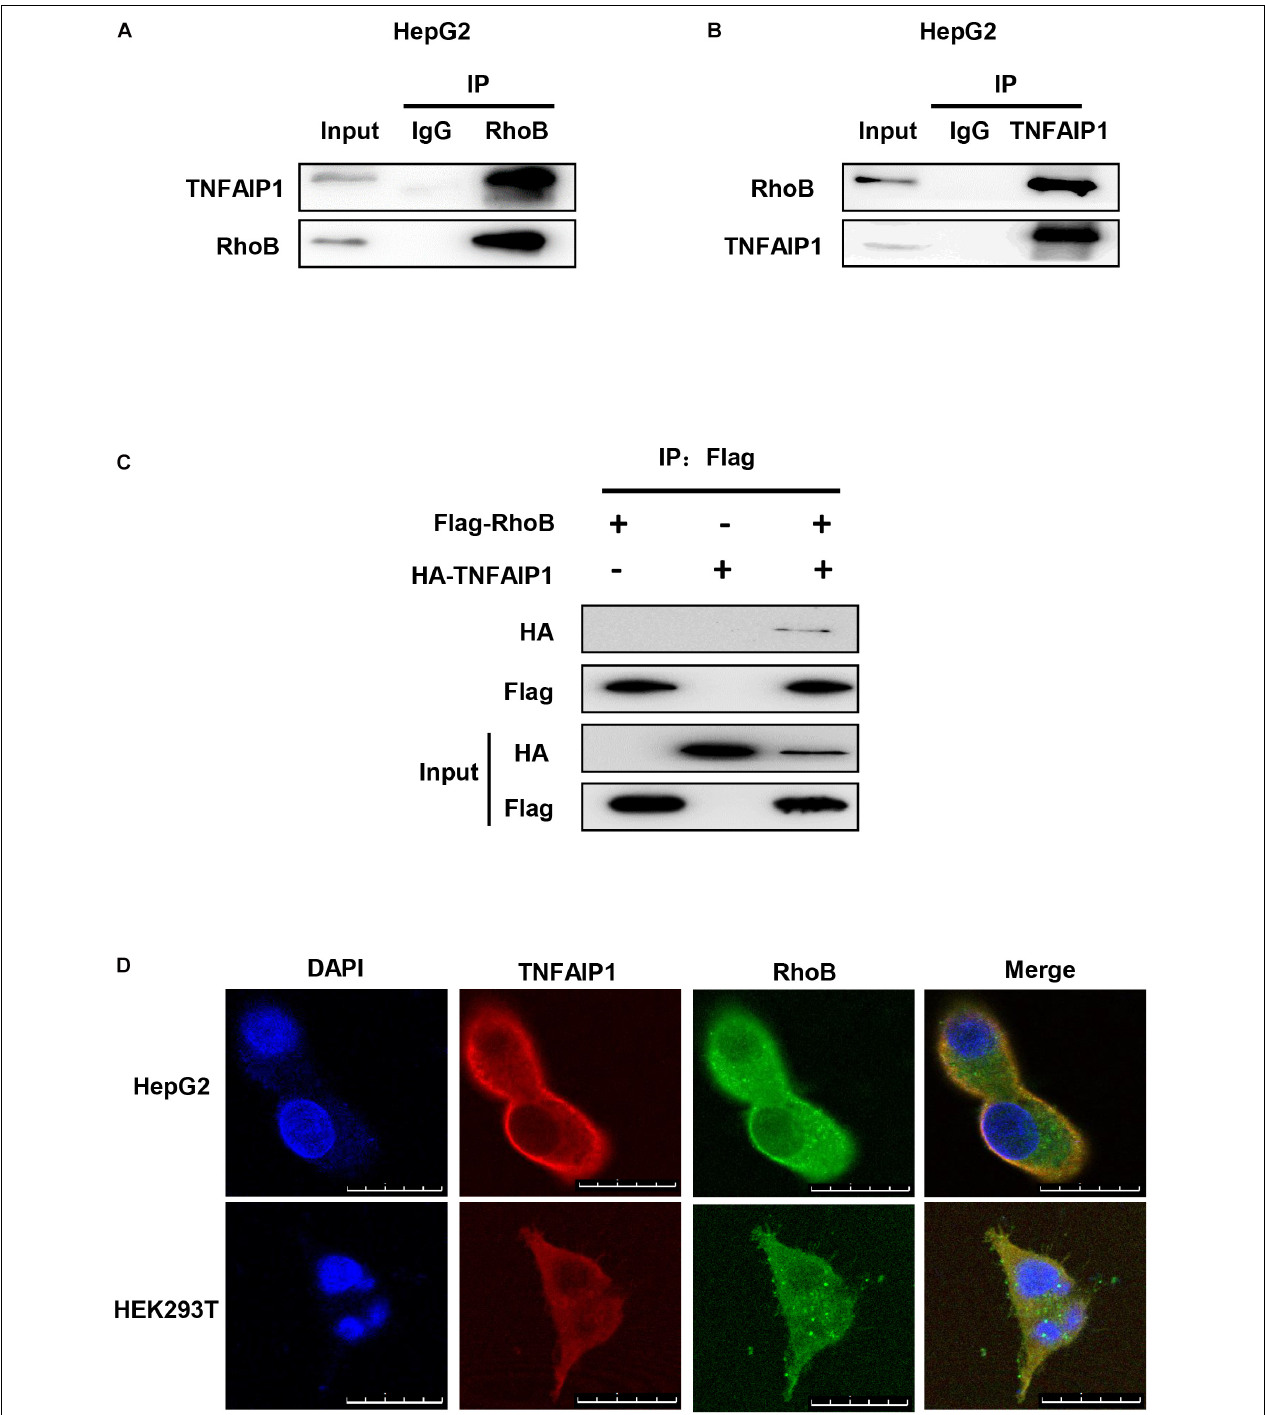
FIGURE 3 | TNFAIP1 interacted with RhoB. (A) Endogenous RhoB interacted with TNFAIP1. HepG2 cells were treated with MG132 (5 µ M) for 6 h, then cells lysates were subjected to immunoprecipitation with anti-RhoB antibody. (B) Endogenous TNFAIP1 interacted with RhoB. HepG2 cells were treated with MG132 (5 µ M) for 6 h, then cell lysates were subjected to immunoprecipitation with anti-TNFAIP1 antibody. (C) Exogenous RhoB and TNFAIP1 bound to each other. Plasmids expressed Flag-RhoB or HA-TNFAIP1 alone or expressed Flag-RhoB and HA-TNFAIP1 simultaneously were transfected into HEK293T cells. Cell lysates were subjected to immunoprecipitation with anti-Flag M2 beads. (D) Endogenous TNAFIP1 and RhoB co-localized in cytoplasm and plasma membrane. HepG2 and HEK293T cells were fixed and stained for TNFAIP1 and RhoB. Bars, 25 µ m.